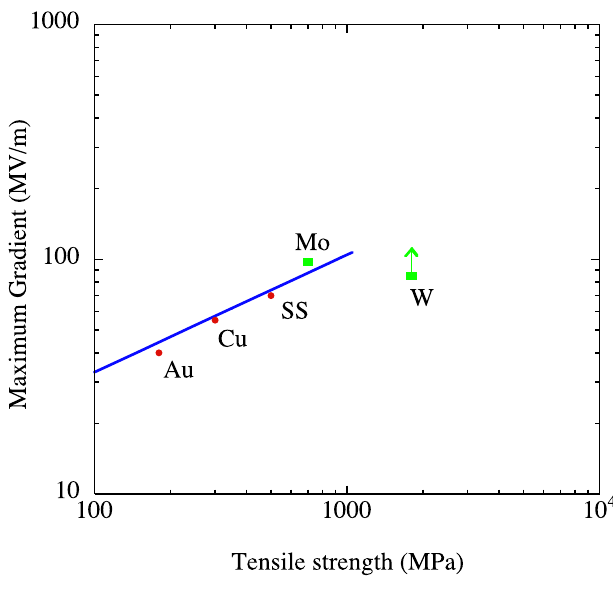
FIG. 9. (Color) Material tensile strength vs maximum observed gradient. Data from SLAC (circles) [33] is presented directly, however data from CERN (squares) [32] is scaled relative to copper, since the pulse length for the CERN data is much shorter. The data on tensile strength is obtained from Ref.